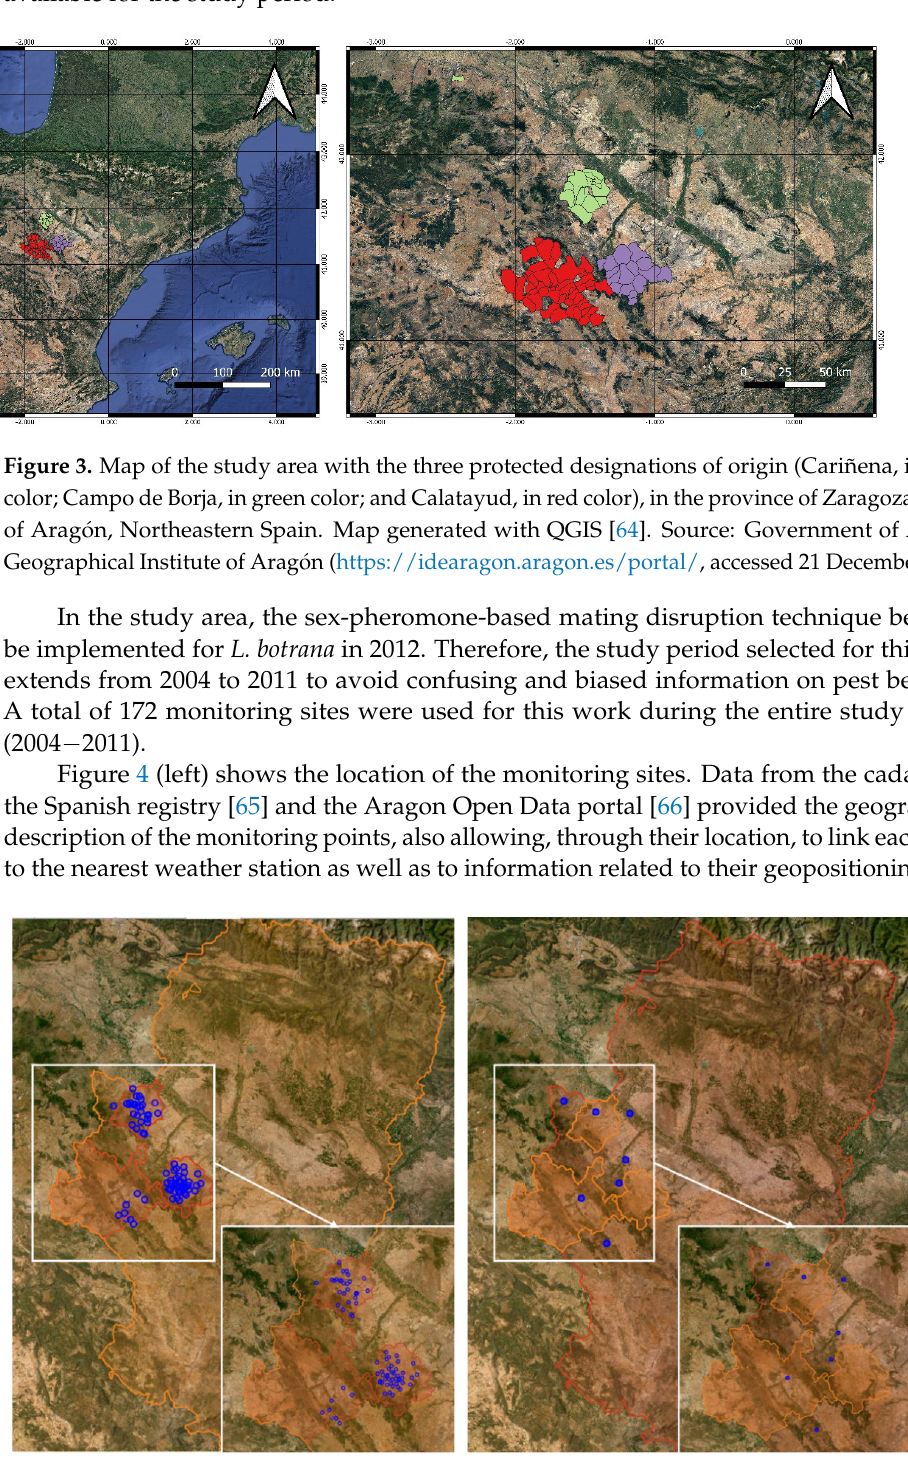
Figure 4. ( Left ) Map with the location of the monitoring sites; ( right ) map with the locations of the weather stations. Source: Government of Aragón-Geographical Institute of Aragón (https://ideara- weather stations. Source: Government of Arag ó n-Geographical Institute of Arag ó n (https://idearagon. gon.aragon.es/portal/, accessed 21 December 2022). aragon.es/portal/, accessed 21 December